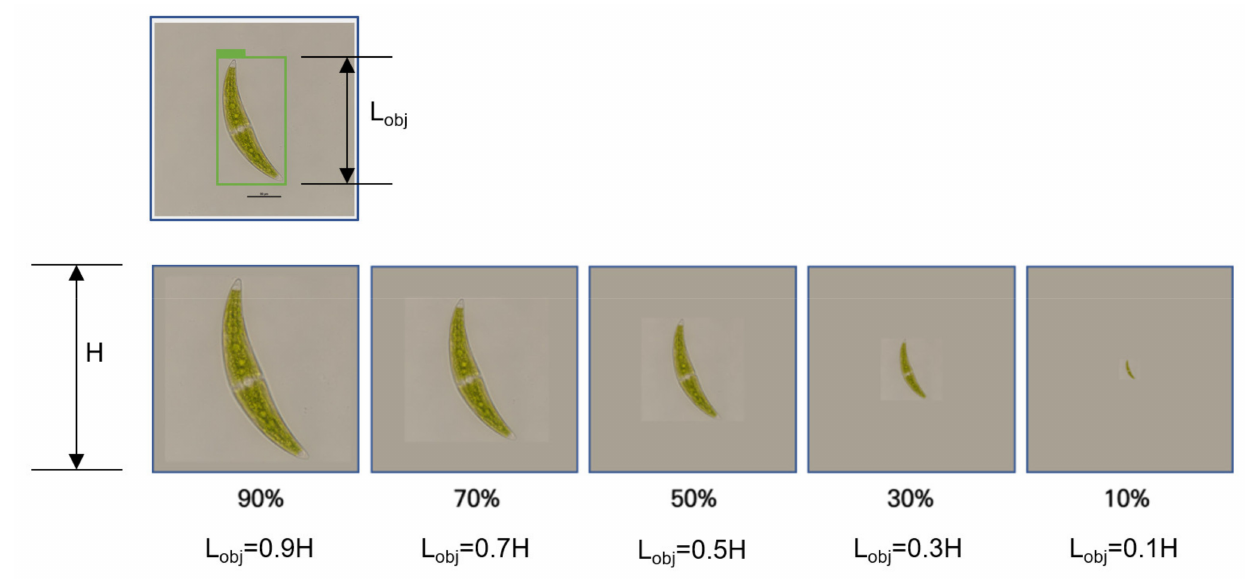
Figure 3. An example image set for testing effect of object